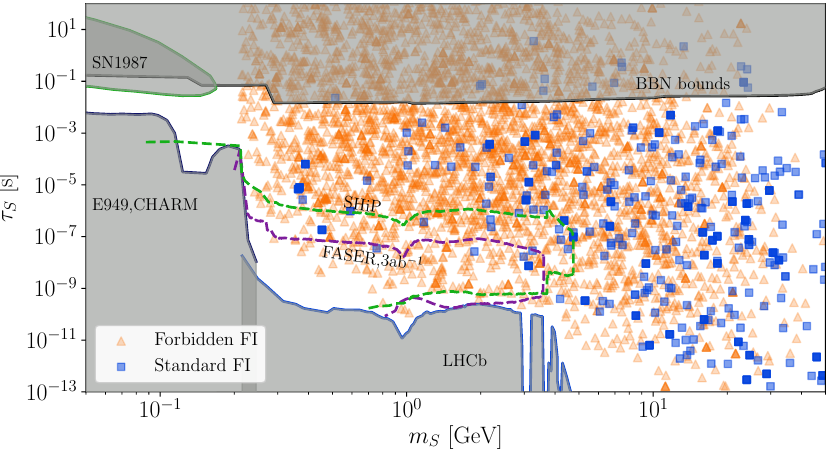
2 m (blue). S > (cid:31)